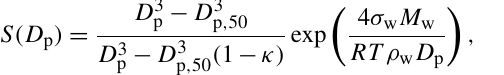
from the chemical analysis of OM and inorganic species was 0.78, 0.58 and 0.64 µg m − 2 s − 1 for mesocosms A, B and